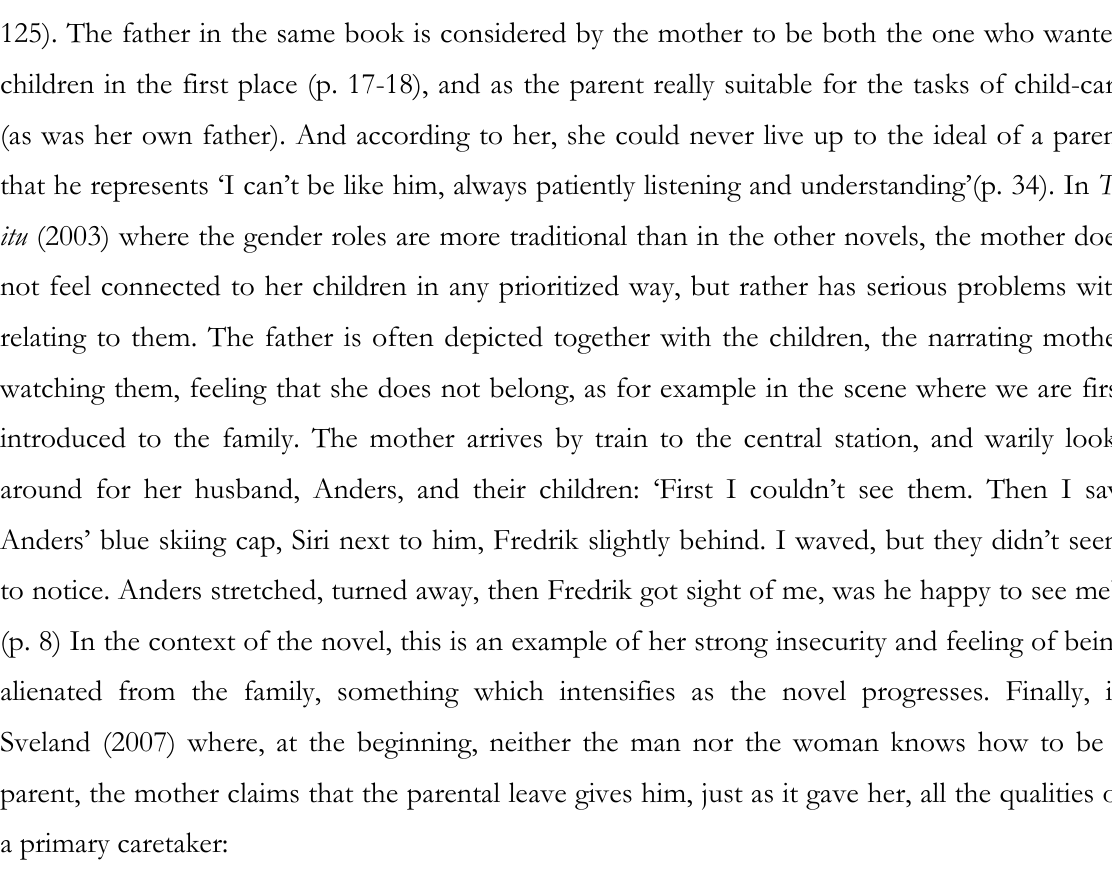
Katarina Carlshamre, Helper and Obstacle: the image of the father in four Swedish mother-narrated novels of the early 21 st Century: Myrén, Nordin, Sandberg and Sveland Studies in the Maternal , 5(2), 2013,